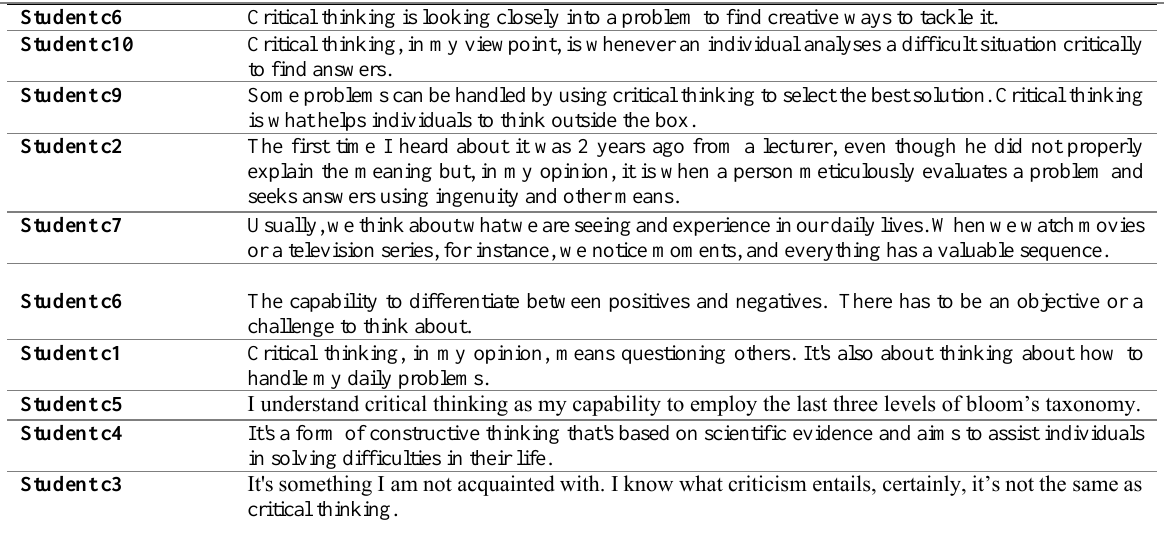
Table 1: Related focus group interview results on critical thinking